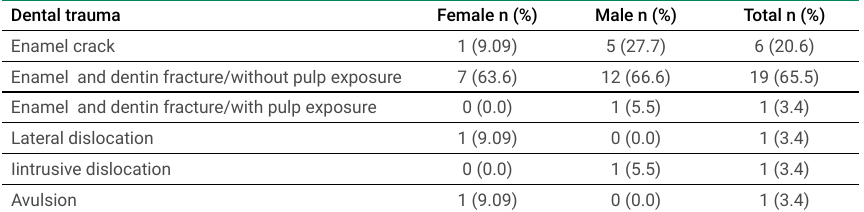
Table 1. Frequency of distribution by gender n (%) of the types of injuries observed (classification according to Andersson et al 14 , 2012). Dental trauma Female n (%)